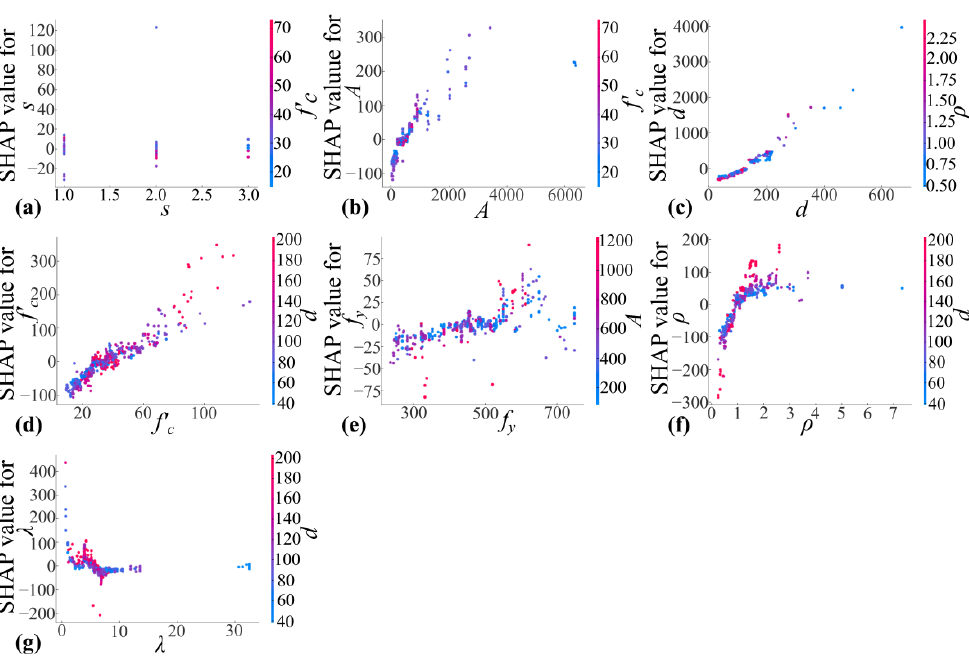
Figure 8. Feature dependencies of influential factors: ( a ) s ; ( b ) A ; ( c ) d ; ( d ) f’ c ; ( e ) f y ; ( f ) ρ ; ( g ) λ